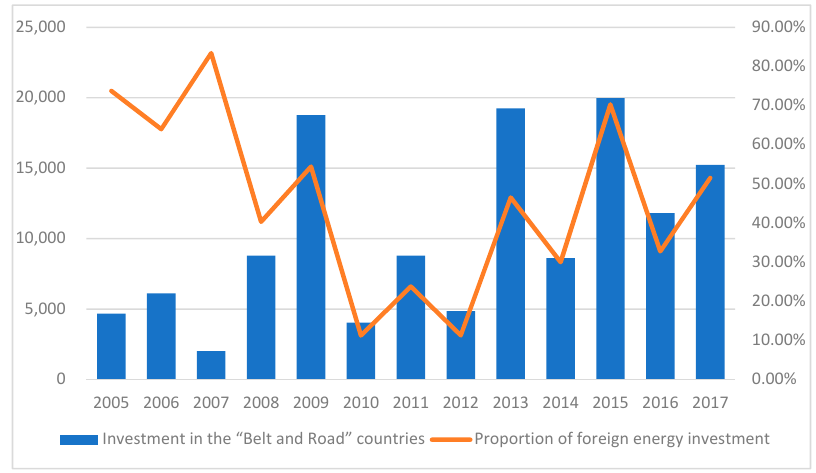
Figure 1. Energy investment in the Belt and Road Initiative (BRI) countries (Unit: USD million). Data source: China Global Investment Tracker.